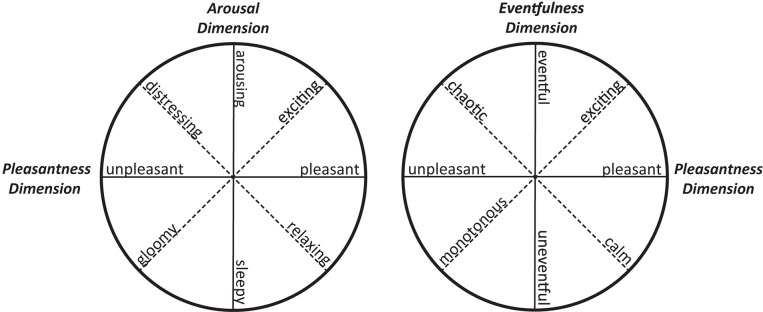
Two-dimensional representation of the affective quality attributed to physical environments generally (left, adapted from Russell et al., 1981) and to acoustic environments in particular (right, adapted from Axelsson et al., 2010).